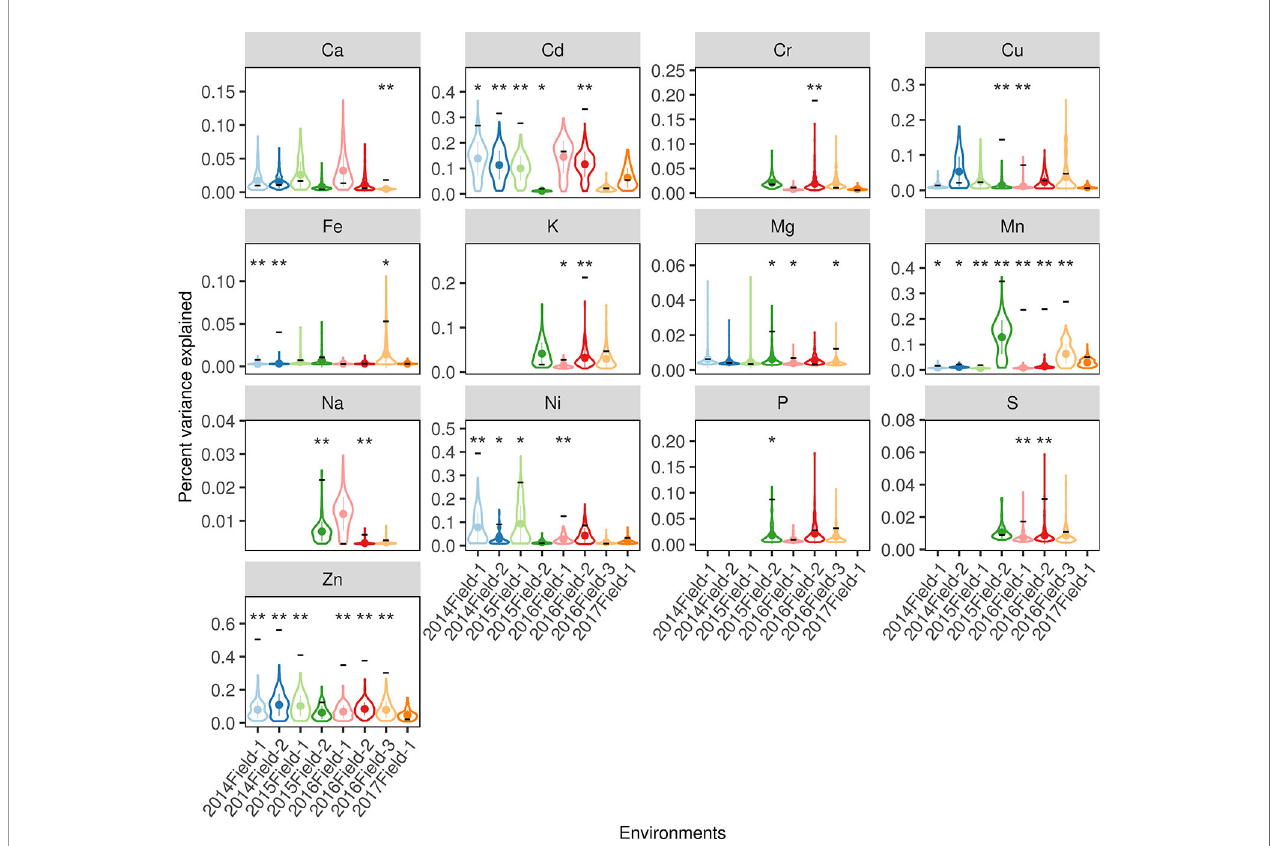
FIGURE 6 | The PVE of the lSALs estimated in each environment. The x-axes indicate the eight planting environments and the y-axes indicate the percent of the variance explained. The violin plots denote the null-distribution of the percent of the variance explained (PVE) estimated from a permutation test with 200 resamplings. The width of each violin denotes the kernel density, the point and line in each violin denotes the mean value and the standard deviation. The black horizontal line located on the violin indicates the real PVE of the lSALs in the corresponding environments. As, Se, and Pb were excluded for their lSALs less than 2. The blanks denote the elemental concentrations were not measured in the corresponding environments. The labels above each violin denote the signi fi cance level if the real PVE was signi fi cantly higher than the null-distribution: “ ** ” indicates a P value < 0.01, “ * ” indicates a P value < 0.05, blank indicates a P value >